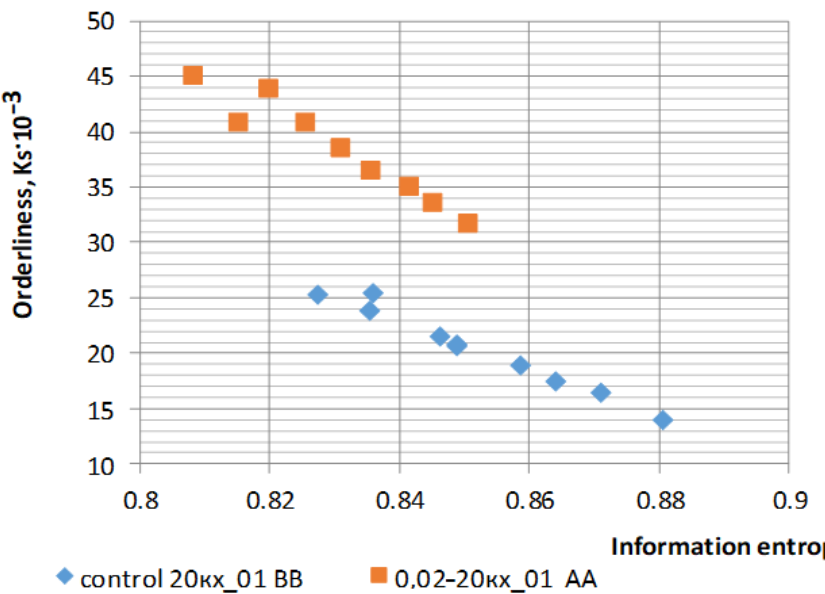
Figure 5. Dependence between the orderliness of K S ∙10 −3 and the information entropy of D 1 in the spectrum of levels of the dynamic deterministic state of the information system.